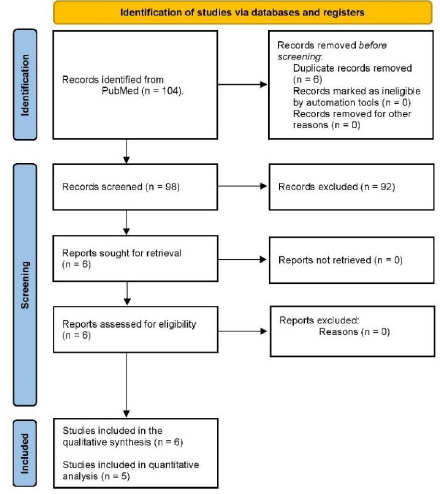
Figure 1. Study flow chart.